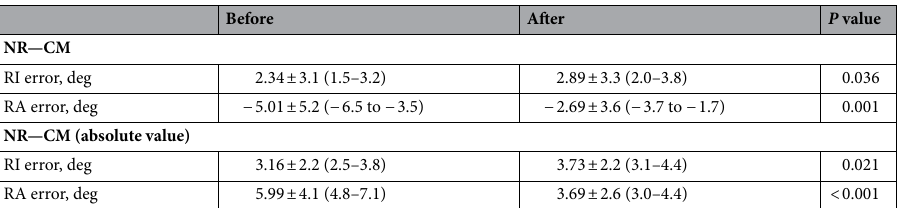
Table 3. The comparison of the cup orientation errors before and after the correction formula was used. Comparisons were performed using the paired t test. The results for continuous variables are presented as the means ± standard deviations, with 95% confidence intervals in parentheses. NR navigation record, CM CT measurement, RI radiographic inclination, RA radiographic anteversion.